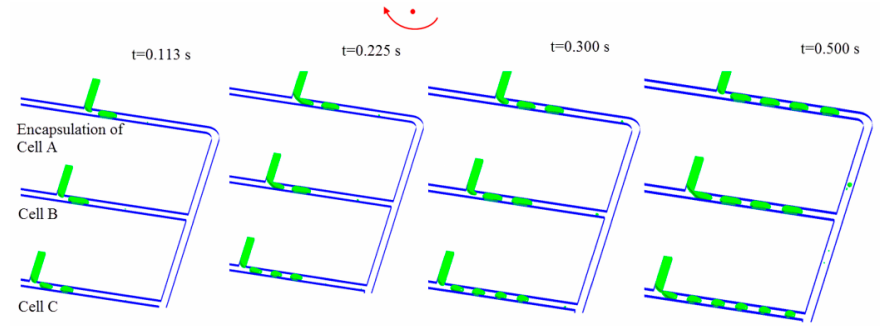
Figure 4. Simulation of encapsulation of multiple types of cells using same centrifugal microfluidic platform. The arrow denotes the direction of rotation. Ω = 50 rad/s.